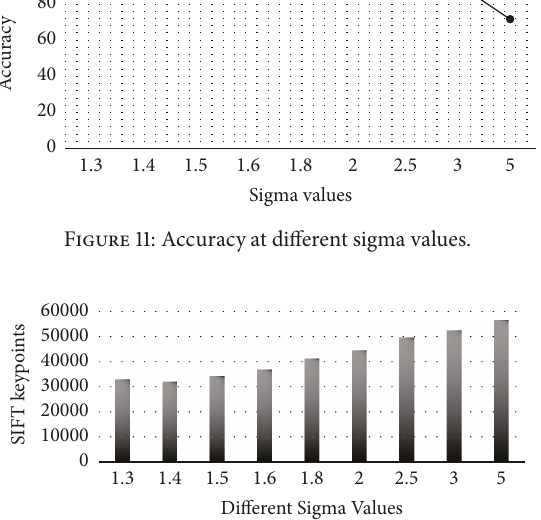
Figure 12: Number of SIFT keypoints at different Sigma